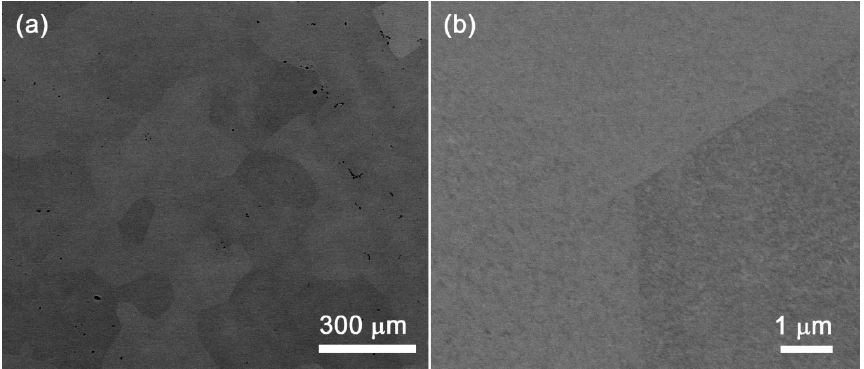
Figure 19. SEM micrograph (back-scattered electrons) of HfNbTaTiVZr alloy annealed at 1200 °C: ( a ) an overview of the microstructure, ( b ) a detail of the grain boundary.